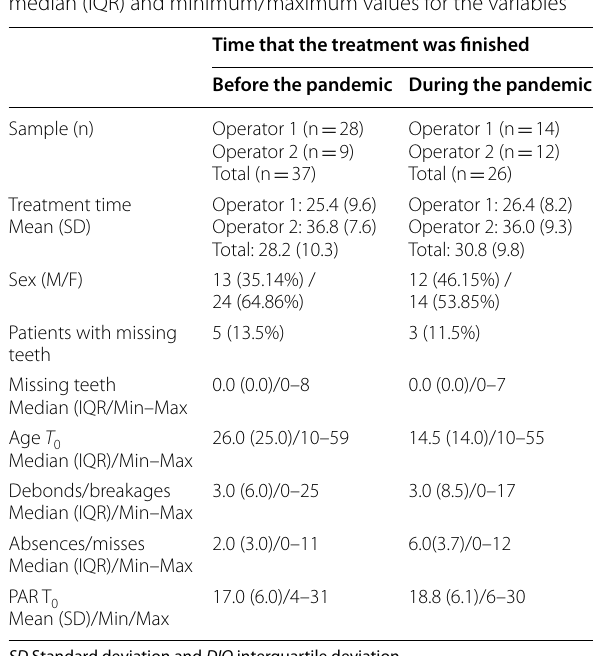
SD Standard deviation and DIQ interquartile deviation Table 2 Number of cases with treatment completed during the